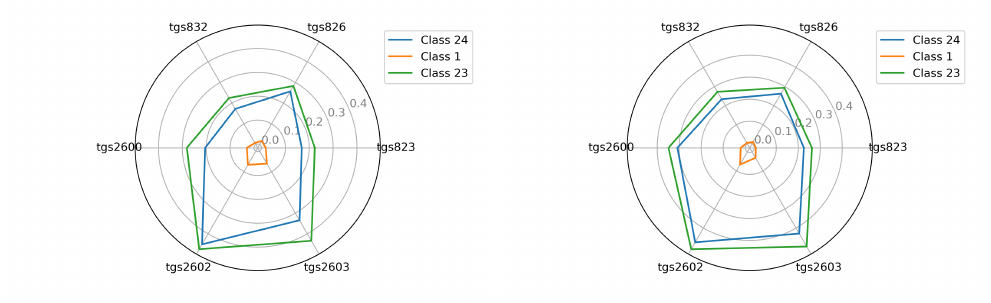
Figure 7. The visualization of the average reading intensity of TGS sensors for decision classes 1, 23, and 24 using M1; wooden chamber on the left and polystyrene chamber on the